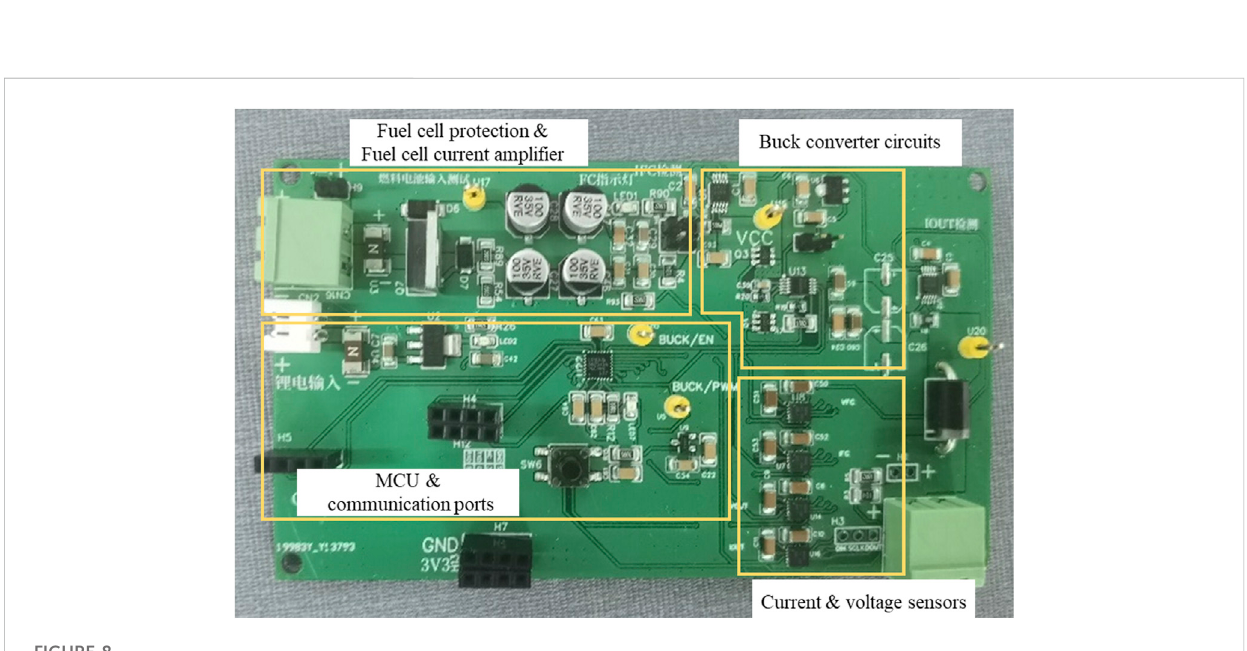
Photo of power regulation